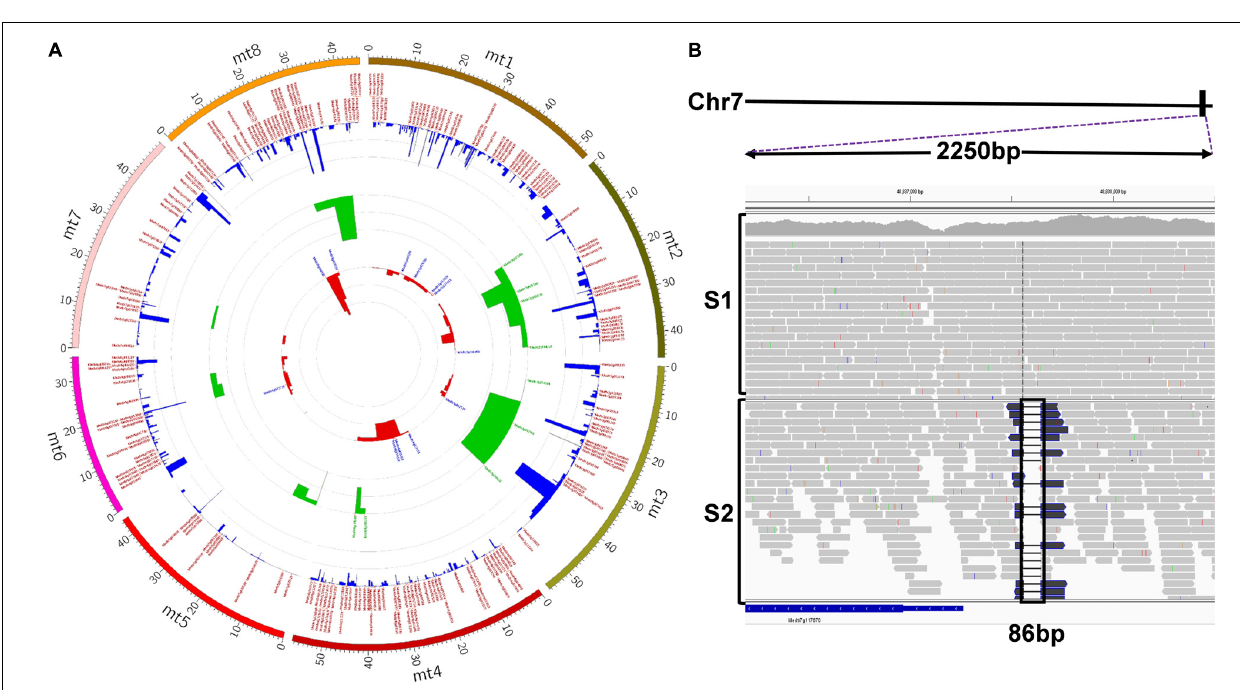
S2 (Supplementary File S1). Out of these deletions, 5,373